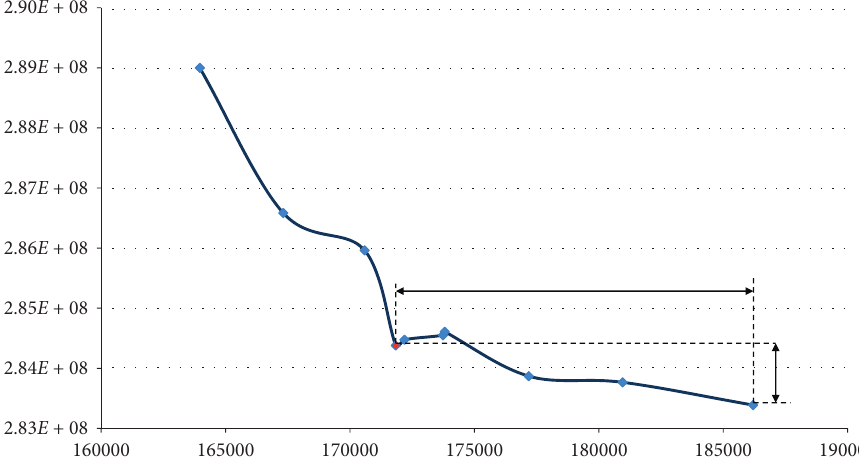
Figure 9: Pareto optimal curves of economic and social objectives.